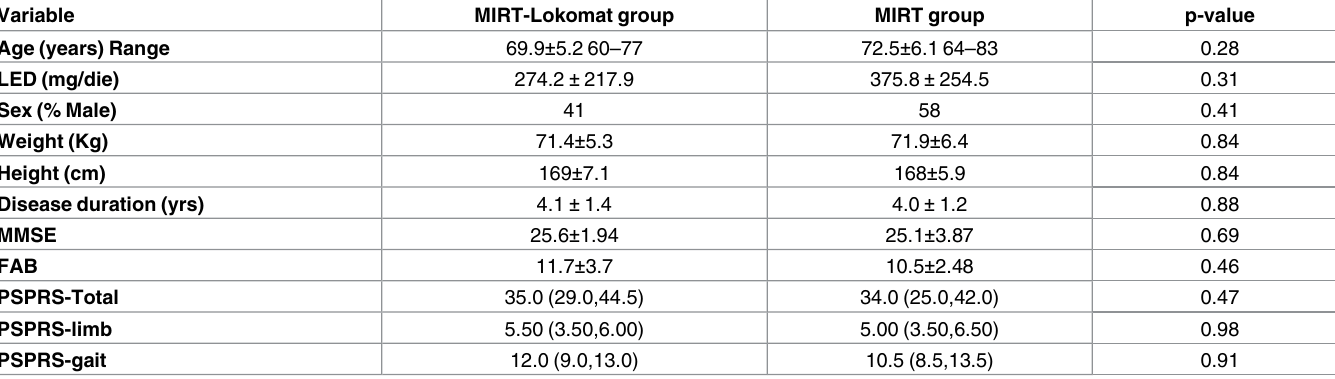
Table 1. Demographic and clinical characteristics of patients assigned to MIRT group and MIRT-Lokomat group. Reportedp-values are computed by the Chi-squaretest for the variableSex, by unpairedt-test for age, LED, weight, height, diseasedurationand by the Mann–Whitney U test for all the other variables. Data are reportedas median(lowerquartile, upperquartile)or mean ± SDfor non-normally and normally data respectivelyand as number(frequency percentage) for discrete variables.